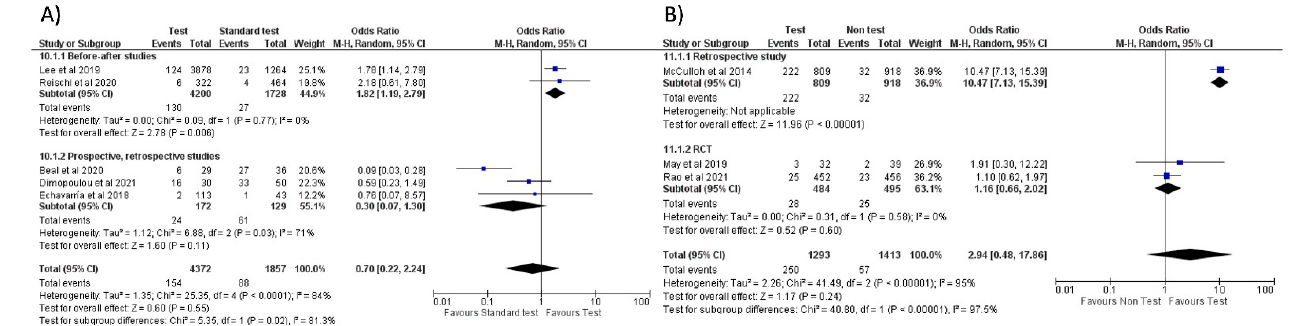
Figure 6. Forest plot of prescription of oseltamivir after implementation of FA-RP: ( A ) FA-RP vs. standard of care; ( B ) FA-RP vs. clinical diagnosis.